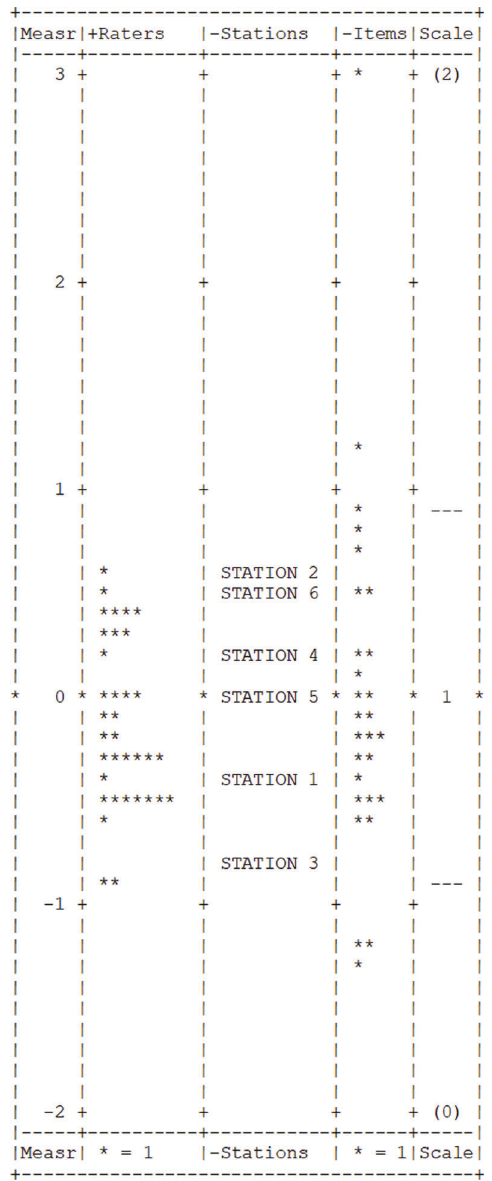
Figure 1 - Yardstick graph with the distribution of parameters from the MFRM